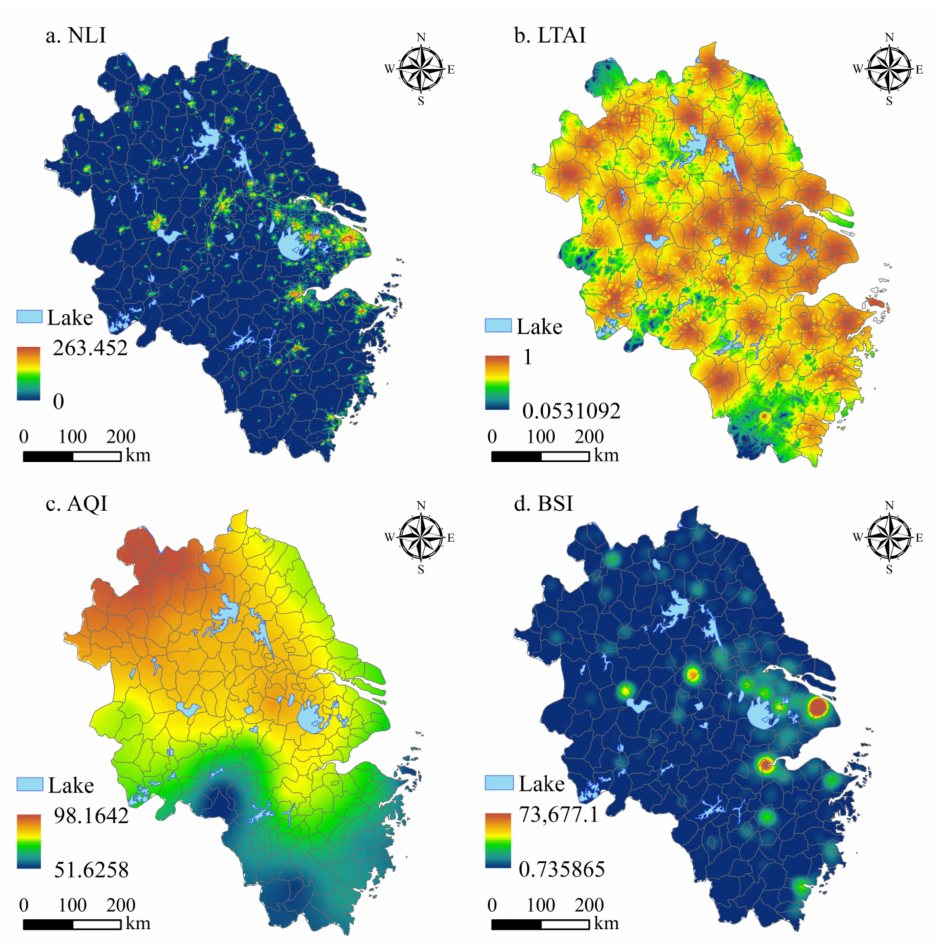
Figure 4. Single-factor spatial distribution of HESI in the